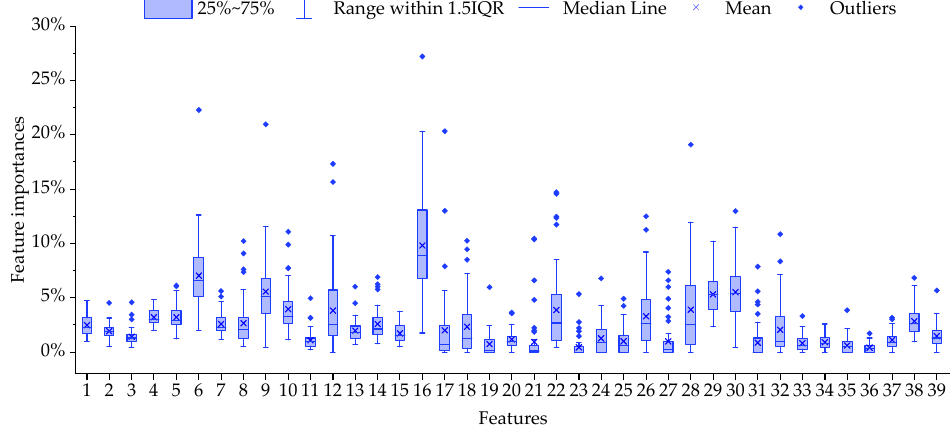
Figure 14. Confusion matrices in liquor experiments. ( a ) The confusion matrix obtained by XGBoost; ( b ) The confusion matrix obtained by LightGBM.